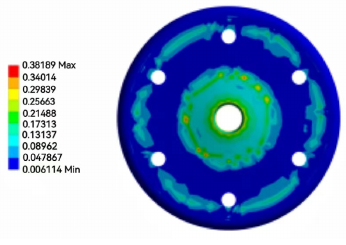
Figure 6. Skin bowl stress in straight pipe.